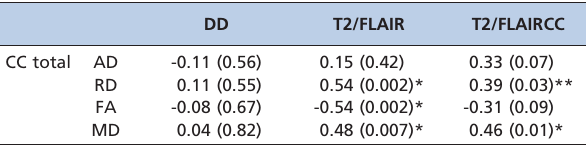
Table 3 - Correlation between disease duration, lesion loads, and diffusion tensor imaging indices of the corpus callosum.